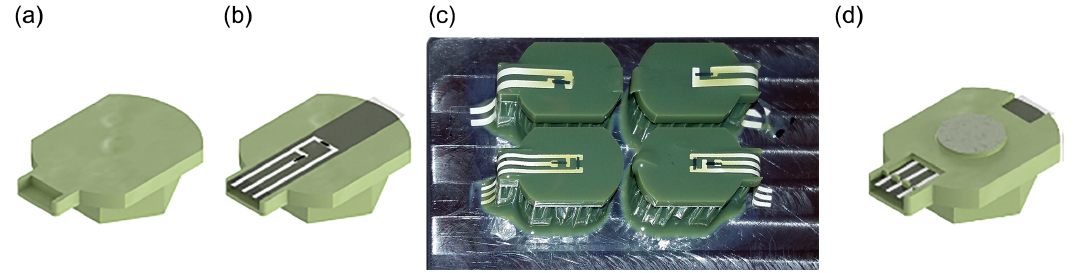
Figure 5. Fabrication process: (a) printing of the screw head; (b) application and alignment of the strain gauge; (c) photography of printed screw heads with applied and aligned sensors continuation; (d) of the printing process. Liquid resin covers the screw heads during the integration and can be seen as a shiny film.